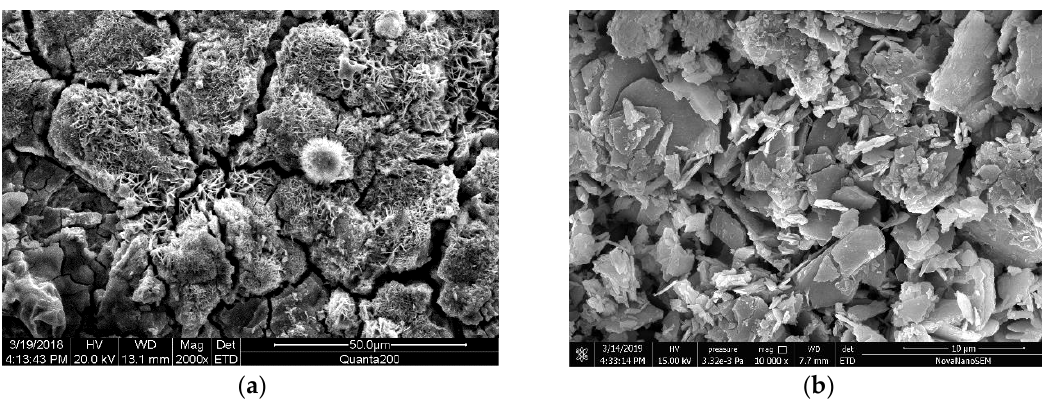
Figure 11. SEM images of rust layer in ordinary concrete under dry-wet cycle; ( a ) Initial rust layer morphology of B2, ( b ) Later rust layer morphology of B2.